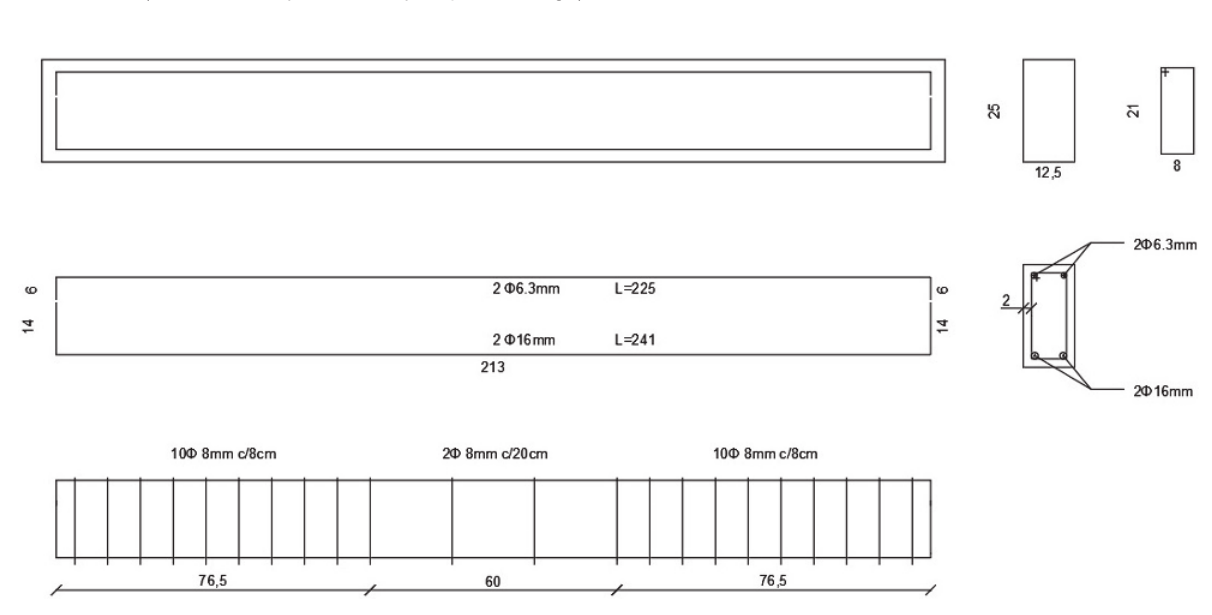
Figura 6 Detalhamento da armadura das vigas de concreto armado com e sem fibras